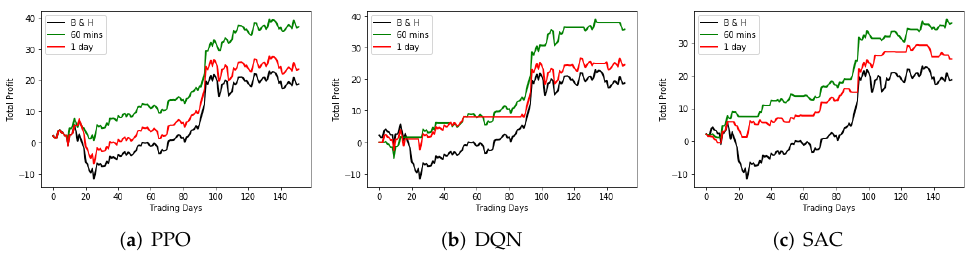
Figure 6. Trading performance on 50 ETF.